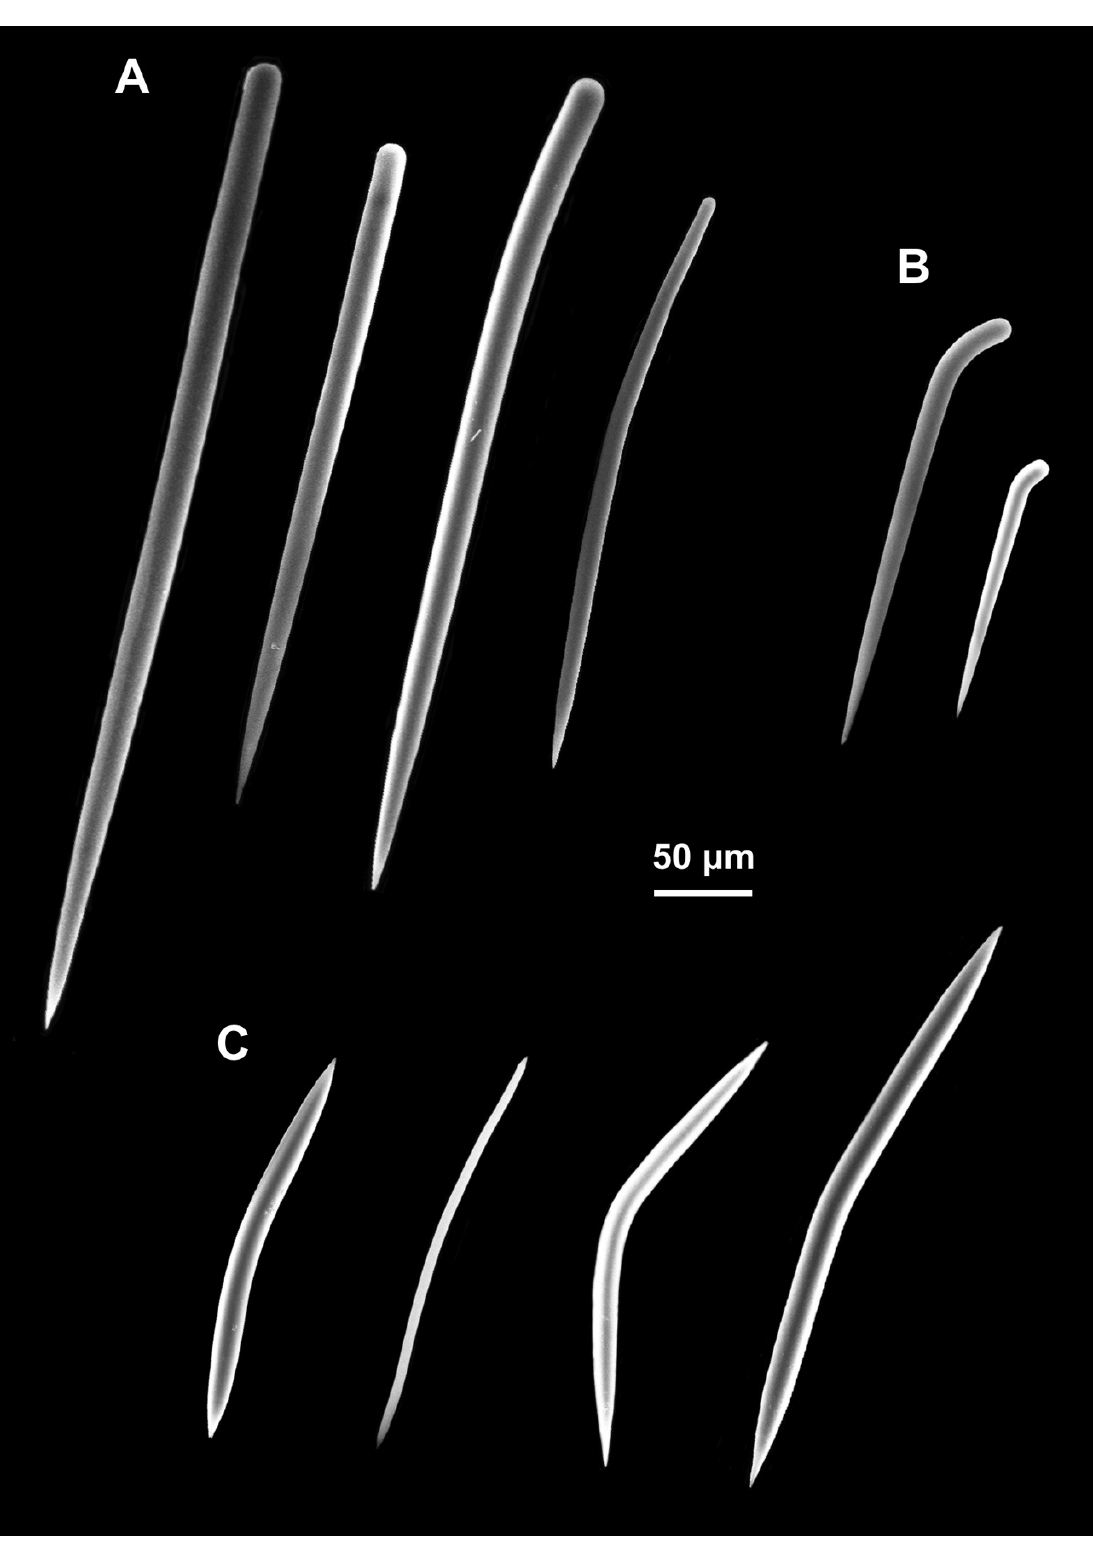
Fig. 4. Spicules of Axinella cylindrica Bertolino, Costa & Pansini sp. nov., holotype (CILE 1; MSGN 61493). A . Smooth styles. B . Rhabdostyles. C .